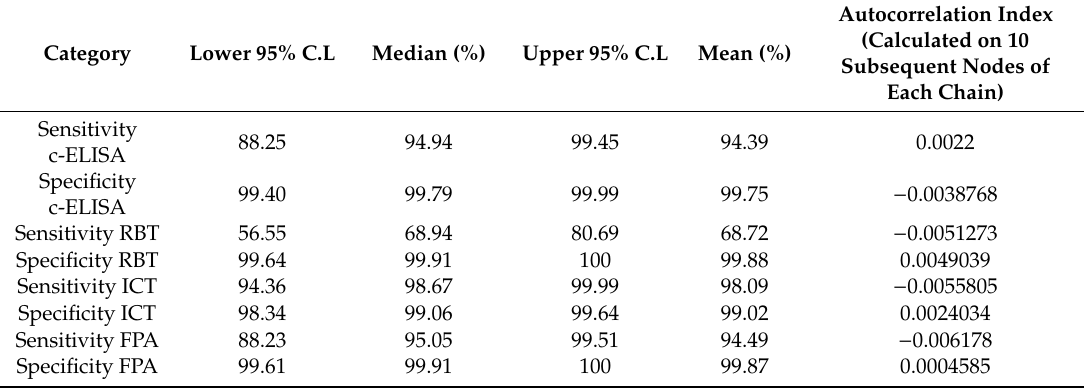
Table 2. Results of the MCMC model—Summary